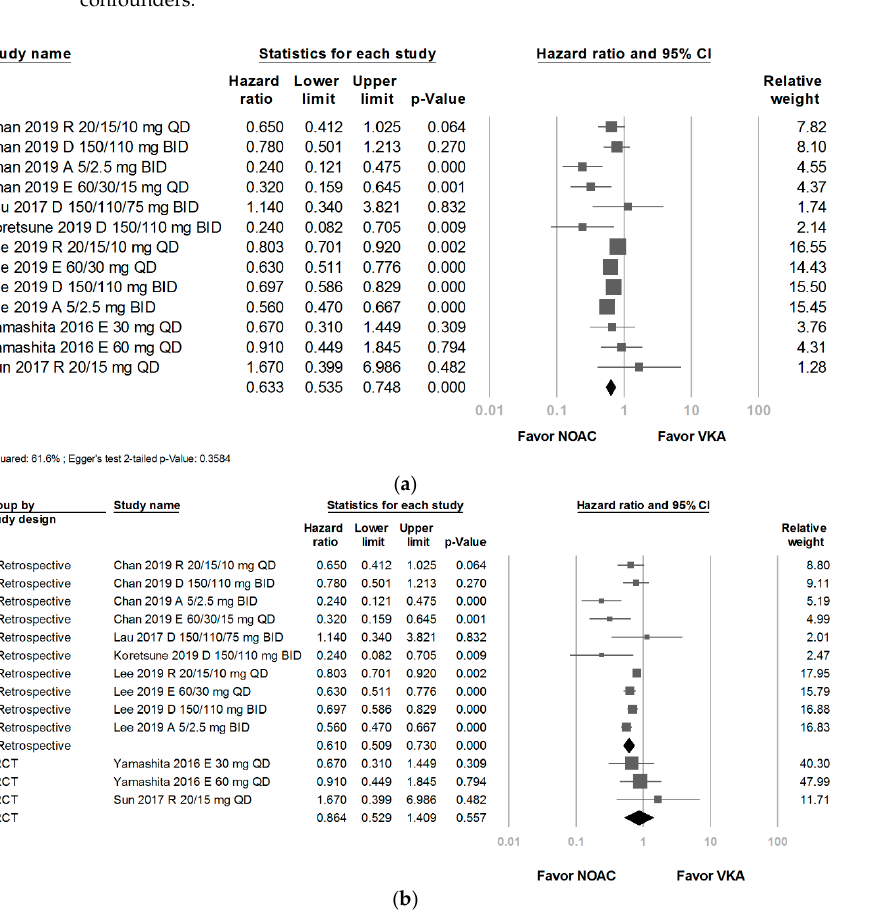
Table 2. Meta-analyses of gastrointestinal bleeding in different groups.